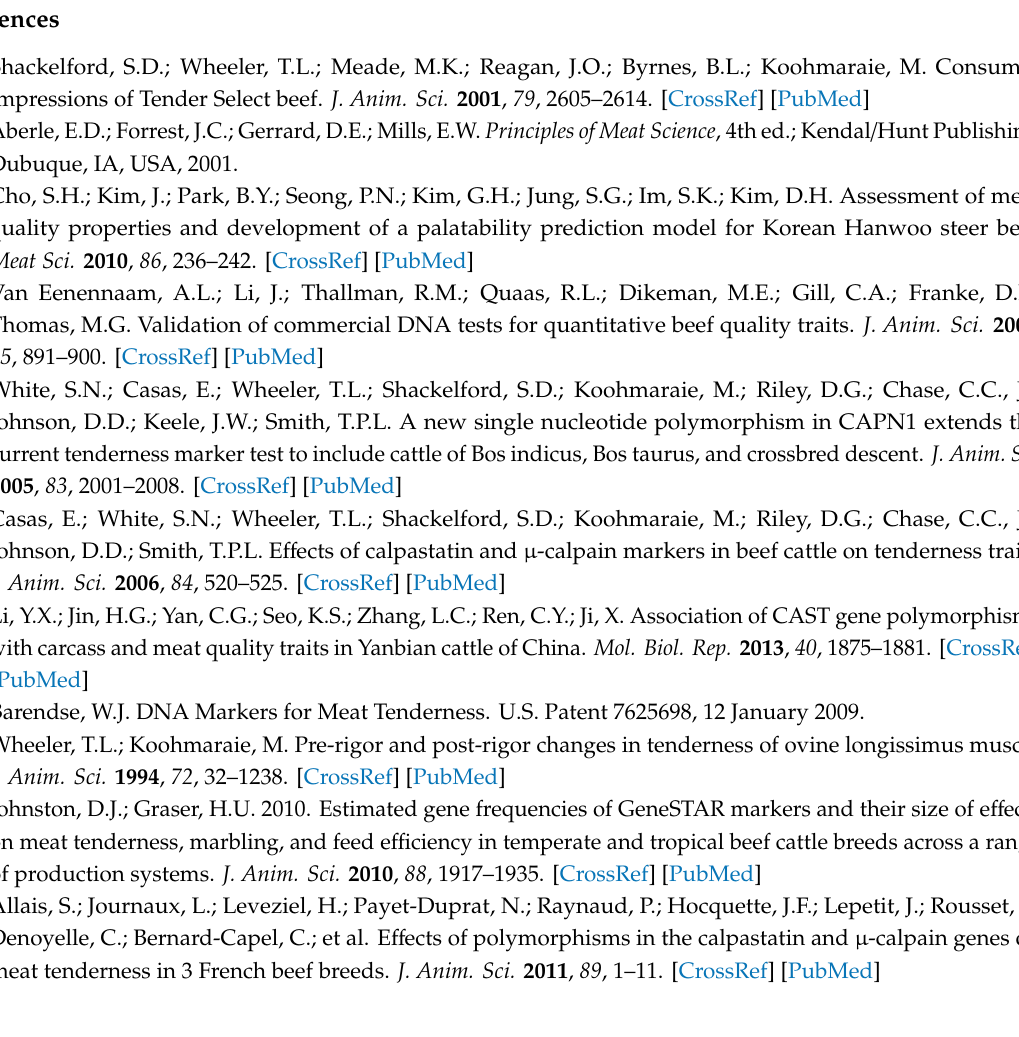
Table S1, Information on the genotyped SNPs, Table S2, Sequences of the Taqman probes used for SNP genotyping, Table S3, Genotype and allele frequencies for 7 selected SNPs in CAPN1-CAST